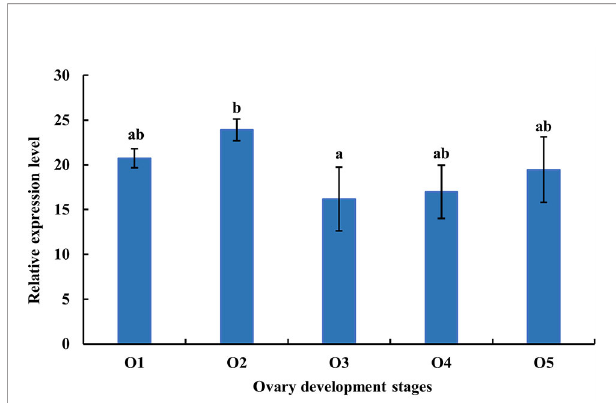
FIGURE 6 | Expression of MnFtz-f1 mRNA in the developmental stages of the ovaries of M. nipponense . O1, undeveloped stage; O2, developing stage; O3, nearly ripe stage; O4, ripe stage; O5, spent stage. Statistical analyses were performed by one-way ANOVA. Data are expressed as mean ± SEM (n = 6). Bars with different letters indicate signi fi cant differences (P <